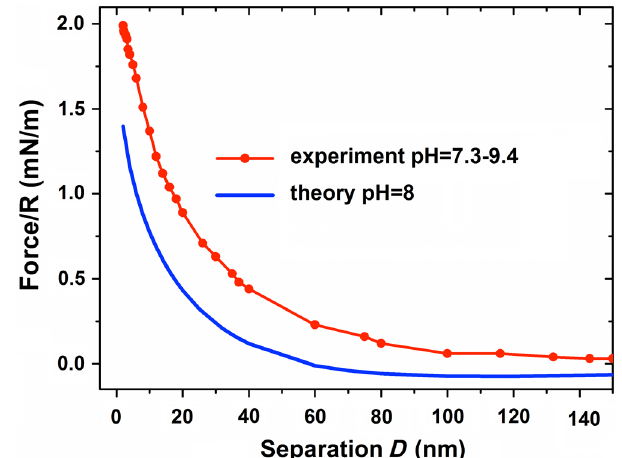
text.FIG. 6. The calculated free energy per unit area of silica surfaces immersed in 1-mM NaNO 3 under pH7, plotted as a function of separation distance between two planar charged